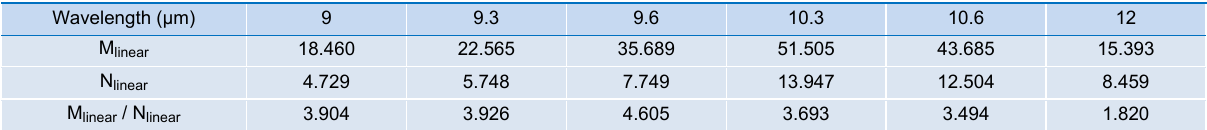
Table 1 | Comparison of the extinction ratio between the polarization-dependent optimization method proposed in this paper and the conventional design method when modulating linear polarization.